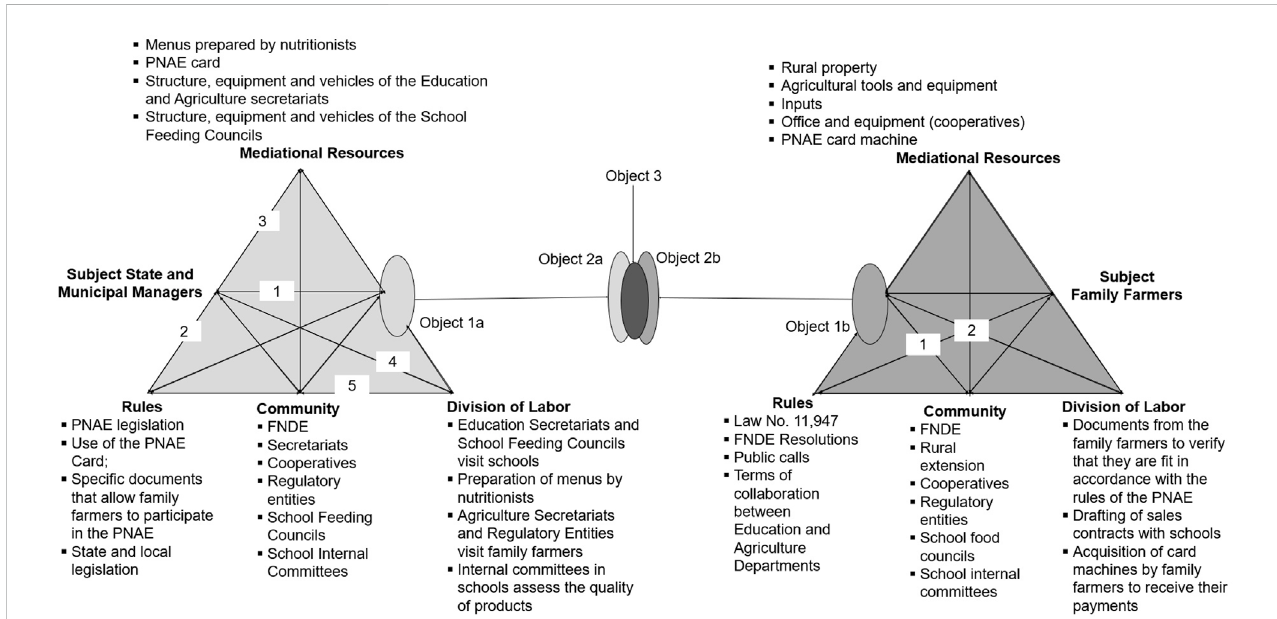
Cultural-historical activity theory (CHAT) and mediated action theory (MAT) used to characterize the activity system generated by Law No. 11,947 in the municipality of Porto Velho, State of Rondônia,